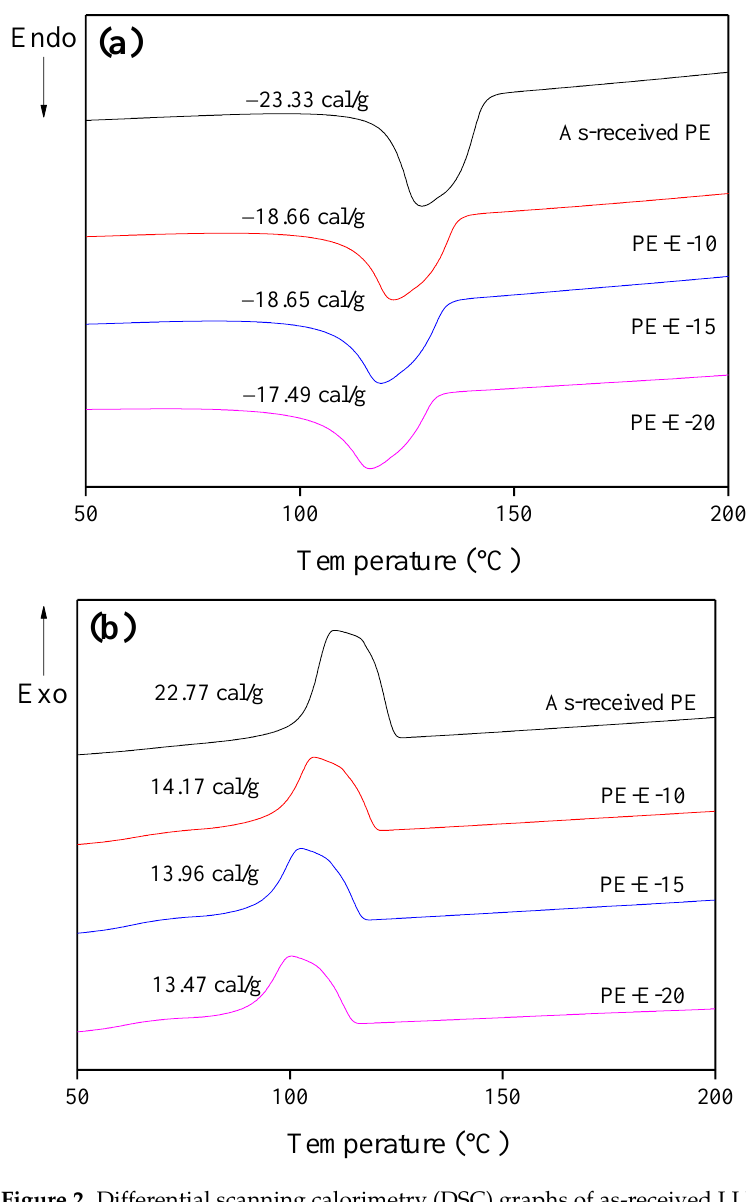
Figure 2. Differential scanning calorimetry (DSC) graphs of as-received LLDPE fibers and E-beam- treated fibers: ( a ) heating, ( b ) cooling. Table 2. XRD result of as-received LLDPE fibers and E-beam-treated